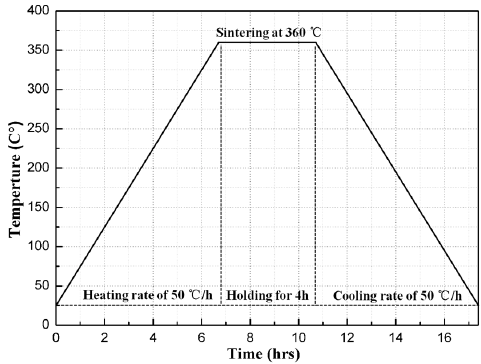
Figure 1. The temperature history of the sintering cycle.